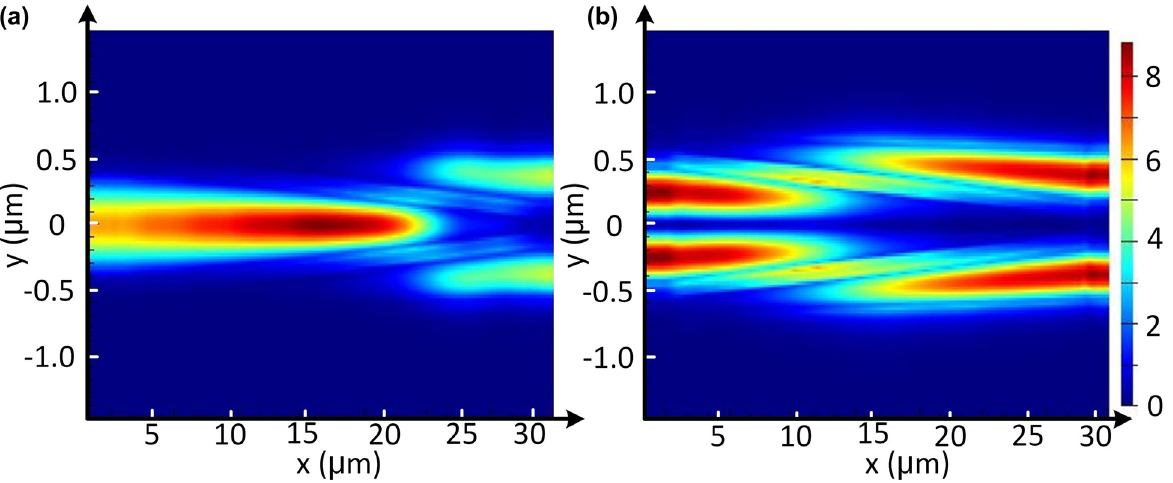
Figure 5: Simulated light propagation in the designed power splitter for the launched TE 0 (a) and TE 1 (b) modes.